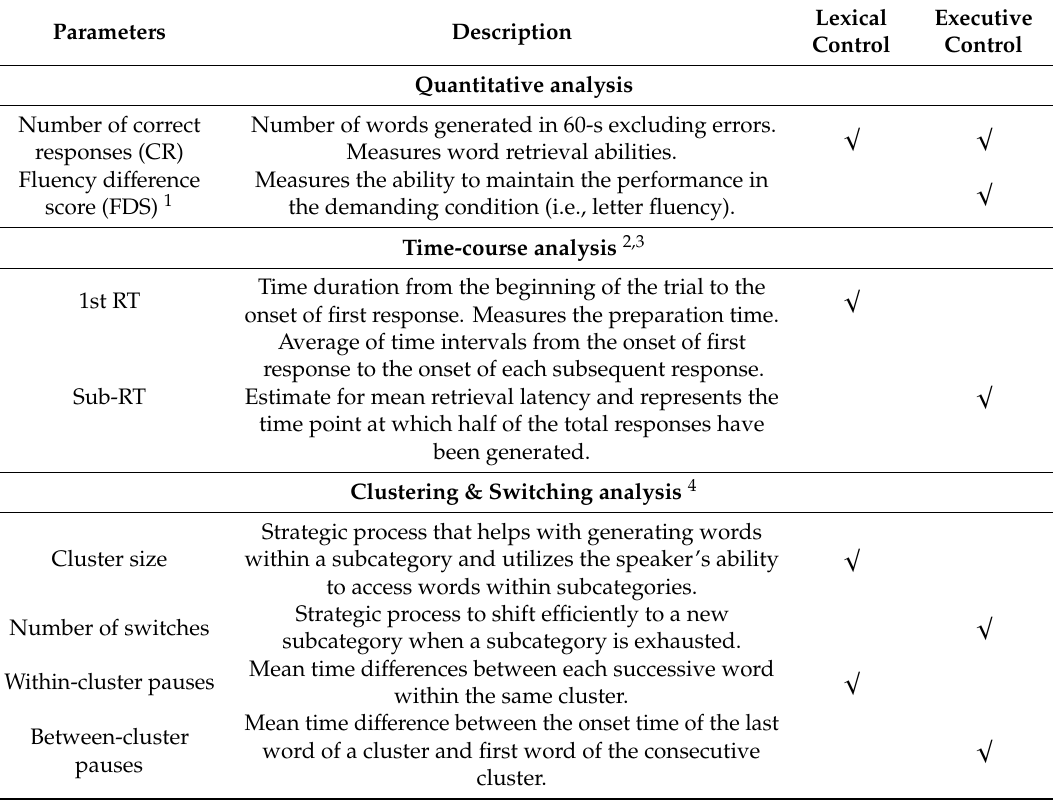
Table 1. Description of the verbal fluency variables and relative contribution of lexical and executive control processes for each of these variables. Adapted from Patra et al.